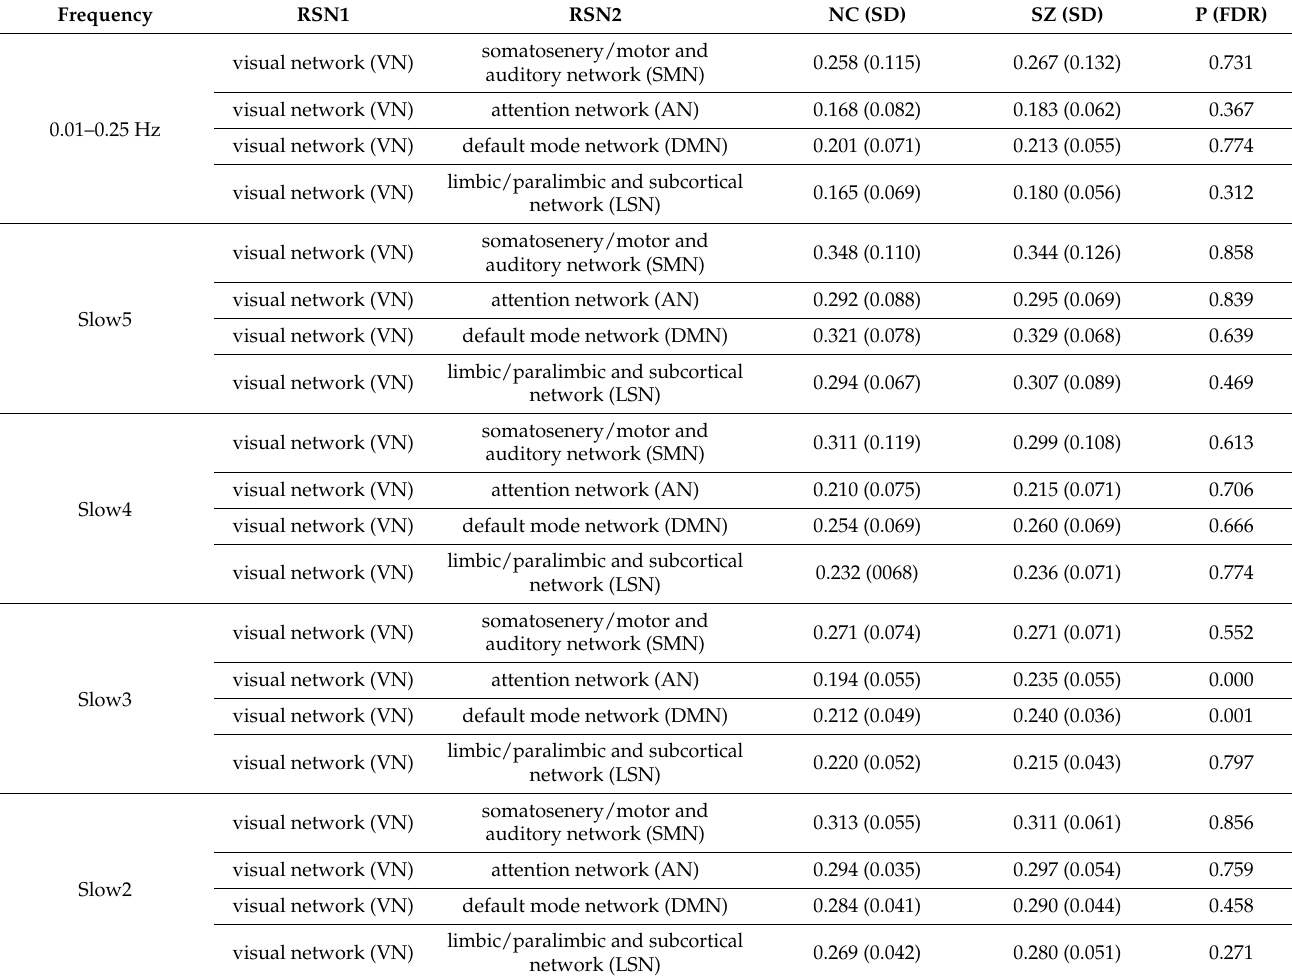
Table 5. RSN-to-RSN integration scores in full frequency (0.01–0.25 Hz), slow5 (0.01–0.027 Hz),